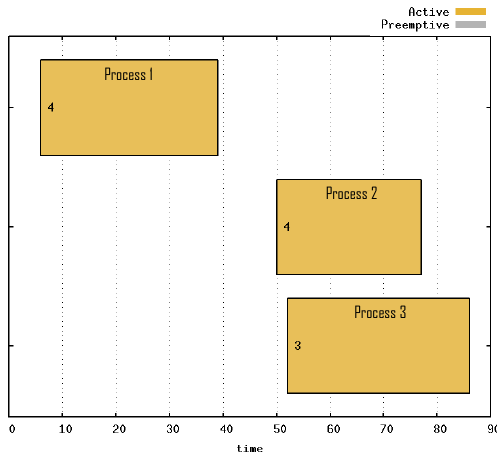
Figure 12. Gantt chart of Fault Recovery for process 2.